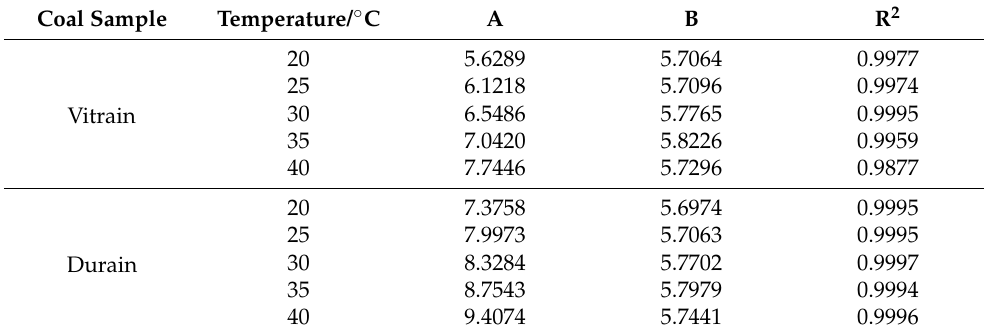
Table 7. ln f -n fitting results of the methane adsorption process at different temperatures.